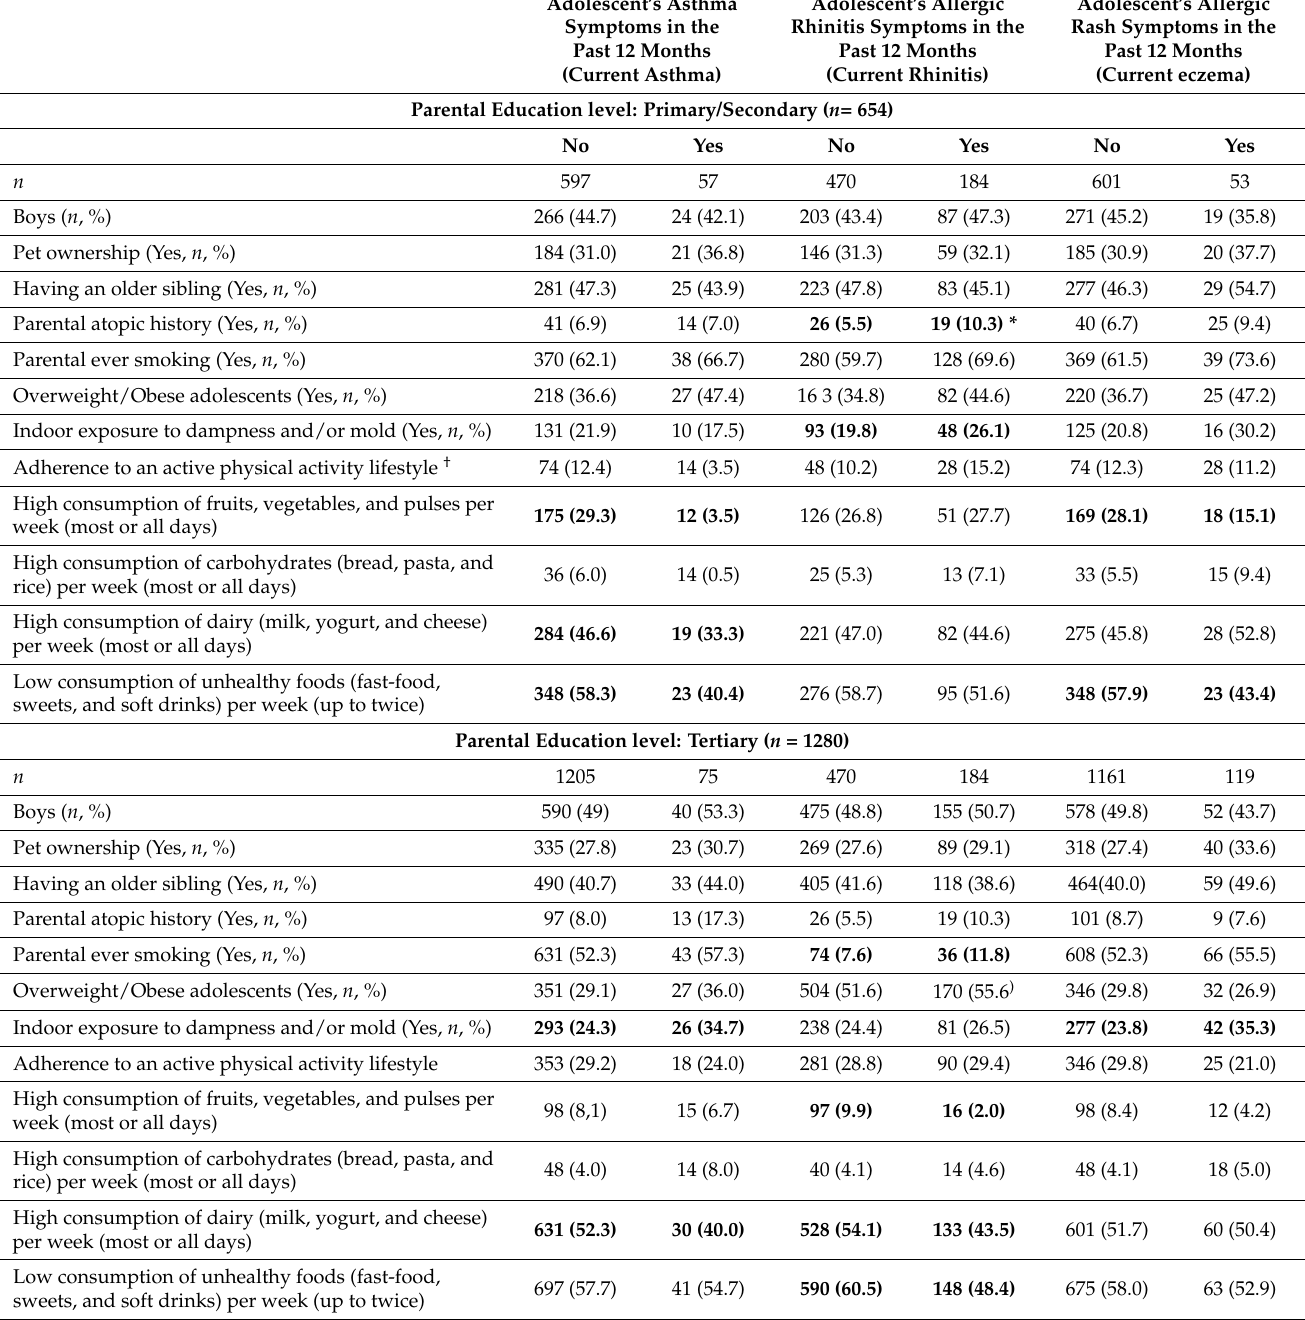
Table 2. Characteristics of the study adolescents according to their atopic diseases’ history status and parental educational level ( n =